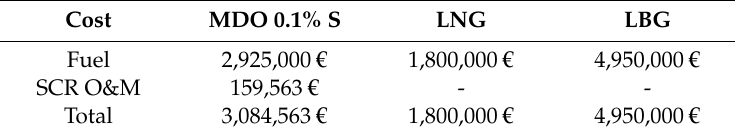
Table 5. Operational costs / one year of RoPax ferry